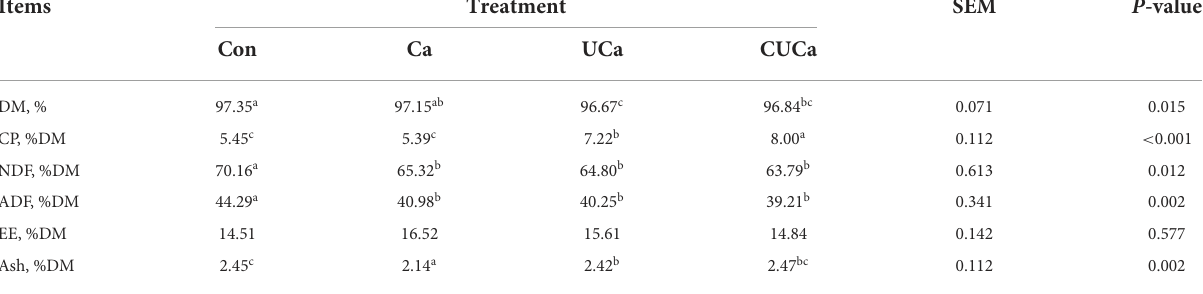
TABLE 1 Effect of CSL plus urea-alkali pretreatment on the chemical composition of rice straw.